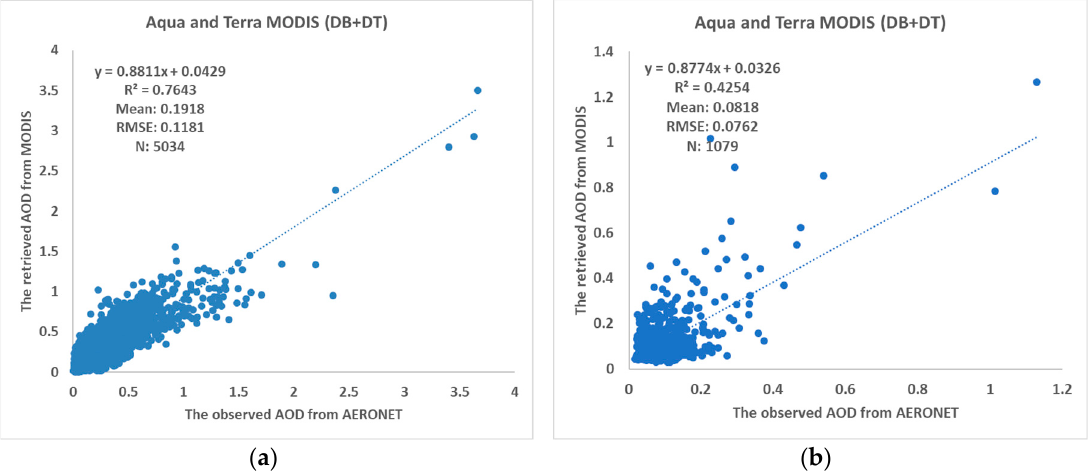
Figure 7. ( a ) The validation of the MODIS deep blue + dark target (DB+DT) algorithm using ground measured AOD from 4 AERONET sites around the world and ( b ) the validation for the MODIS DB+DT algorithm at Dalanzadgad site only (right). Note MODIS has observations twice daily, therefore it has a large number of data samples (~5000 in total). On the other hand, the revisiting period of Sentinel-2/MSI is 10-day before July 2017 and 5-day after July 2017, respectively. The ratios of the numbers of observations between MSI and MODIS are 1/20 and 1/10, respectively.